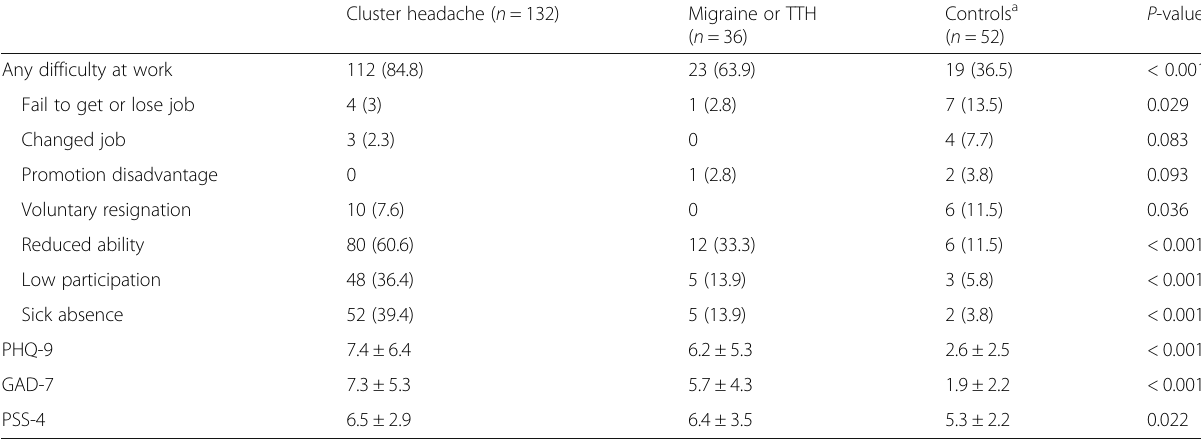
Table 2 Job burden, depression, anxiety, and stress profiles in patients with cluster headache, patients with migraine or TTH, and controls among patients with current job Cluster headache ( n = 132) Migraine or TTH ( n =